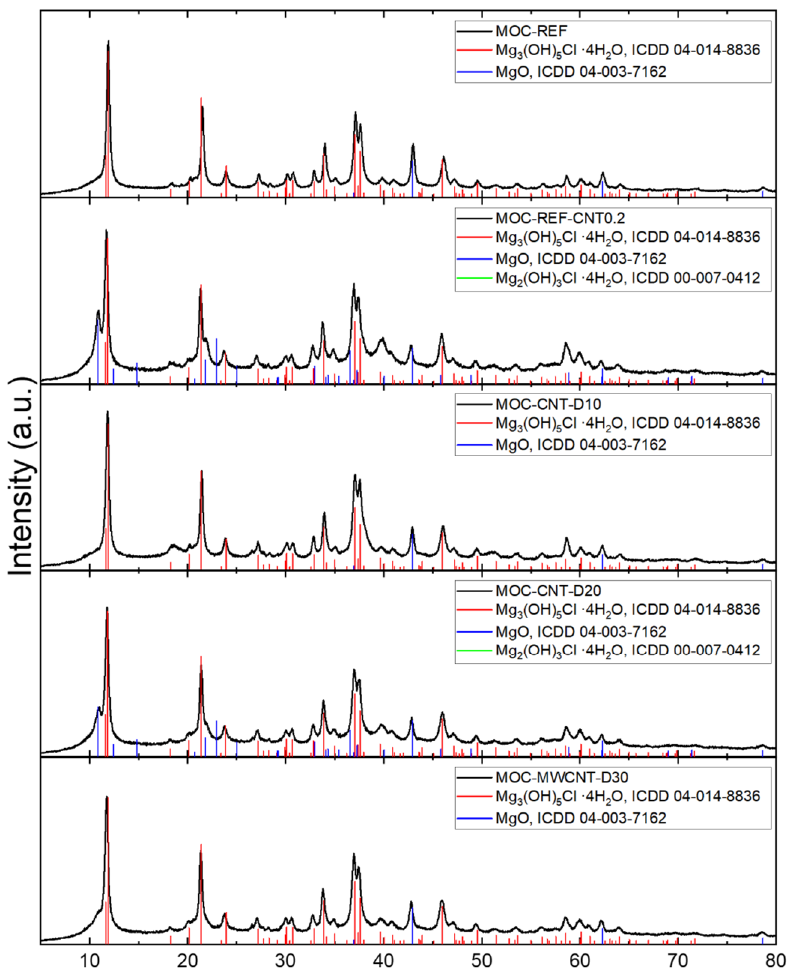
Figure 4. The diffractograms of the samples MOC-REF, MOC-REF-CNT0.2, MOC-CNT-D10, MOC- CNT-D20 and MOC-CNT-30 .